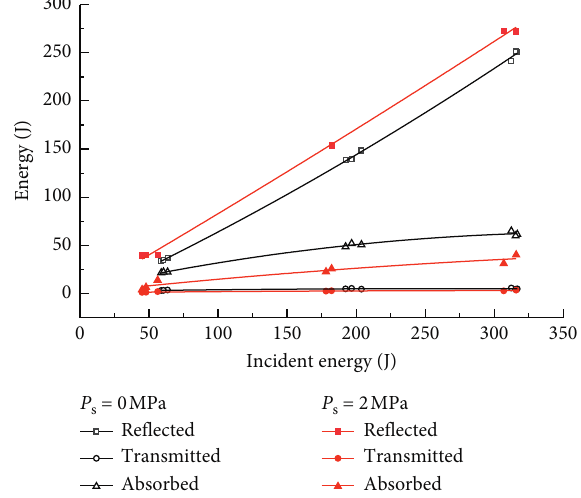
Figure 11: The variation in reflected energy, transmitted energy, and absorbed energy with incident energy.